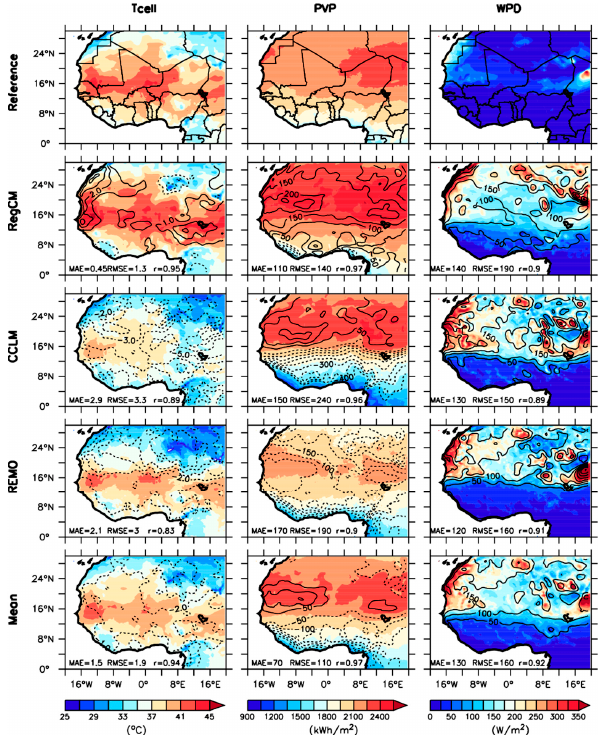
Figure 4. Same as Figure 3, but for cell temperature (T cell ), photovoltaic potential (PVP), and wind power density (WPD).